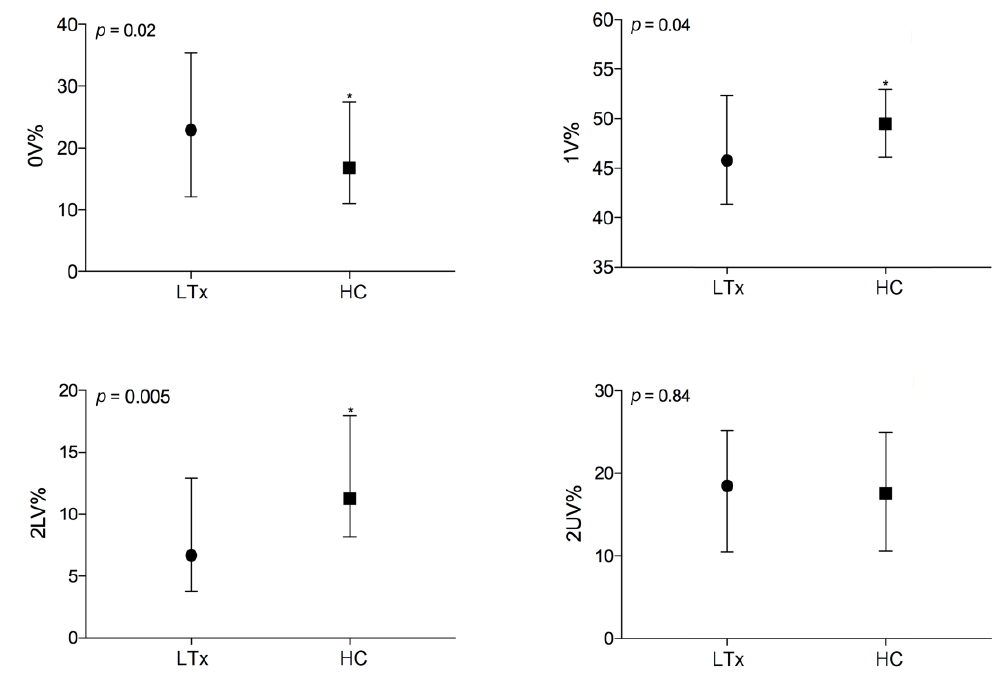
Figure 1. Comparison of autonomic parameters evaluated by symbolic analysis between healthy controls (HC, n = 49) and patients on the waiting list for lung transplant (LTx, n = 49) in supine position; *, statistically significant.